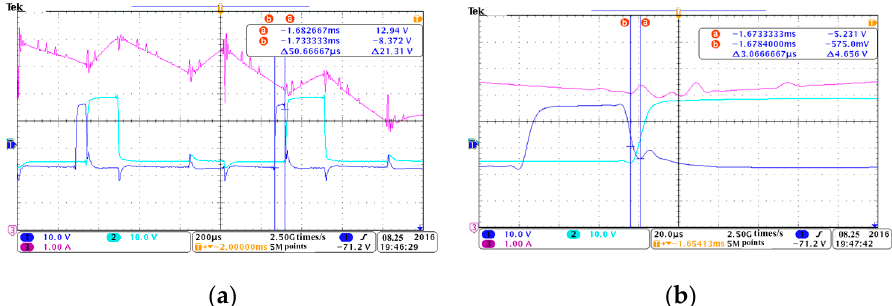
Figure 17. Parameters under desaturation control: ( a ) desaturation pulse width 50 μ s; ( b ) lock time 3 μ s.